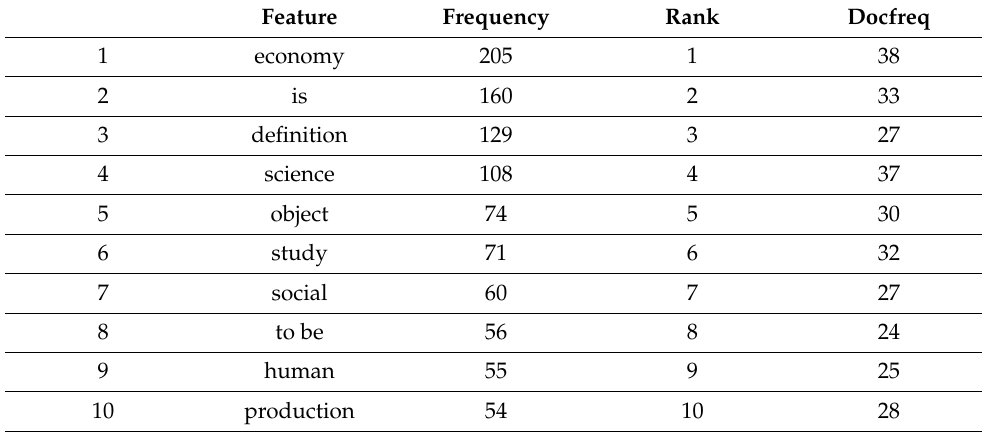
Table 2. The ten most frequent words in data set